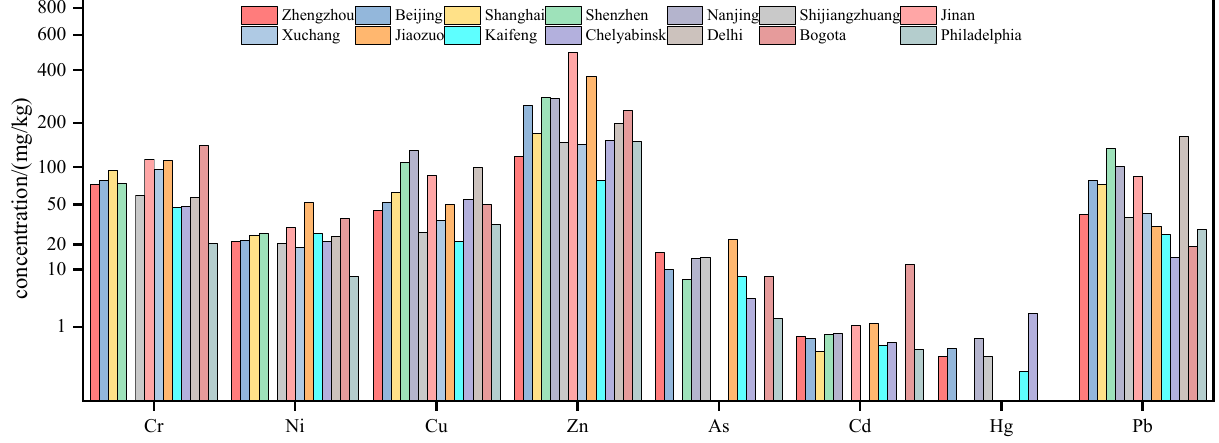
Figure 2. Comparison of PTEs (mg/kg) in road dust with the previous literature. (Beijing [18], Shanghai [19], Shenzhen [20], Nanjing [21], Shijiangzhuang [22], Jinan [23], Xuchang [24], Jiaozuo